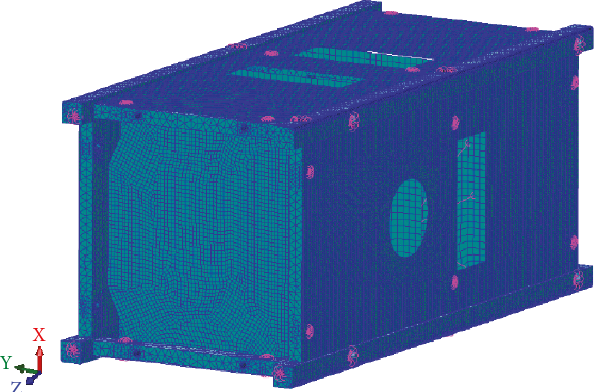
Figure 4: Finite element